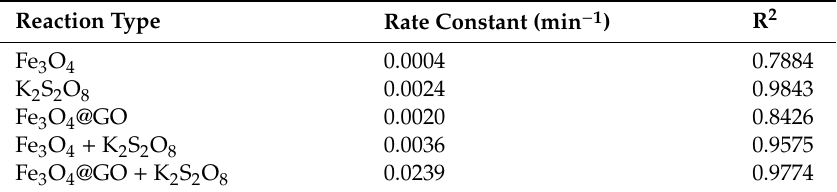
Table 1. Kinetic rate constants of the pseudo-first-order